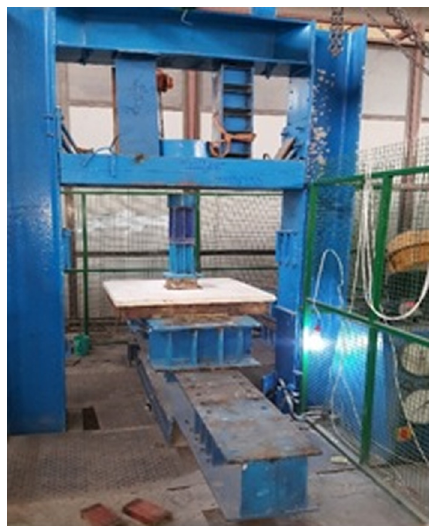
Figure 6: The hydraulic static testing equipment.